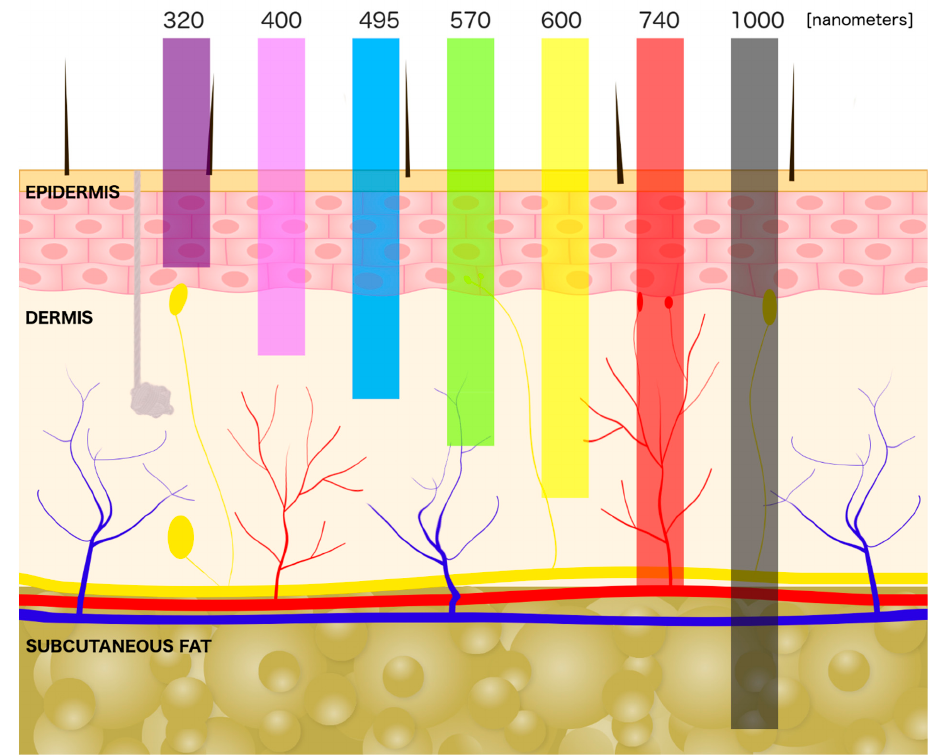
Figure 1. The skin cross-section showing dermal penetration by different wavelengths of light (in order from the left: UVB, UVA, blue light, green light, yellow light, red light, infrared light). More specific knowledge of this interaction between laser and skin can help the specialist to select specific laser parameters in their therapies, such as the wavelength of the laser light, intensity, duration of radiation, and the density of laser beam energy [19]. Some medical uses of lasers are presented in Figure 2.